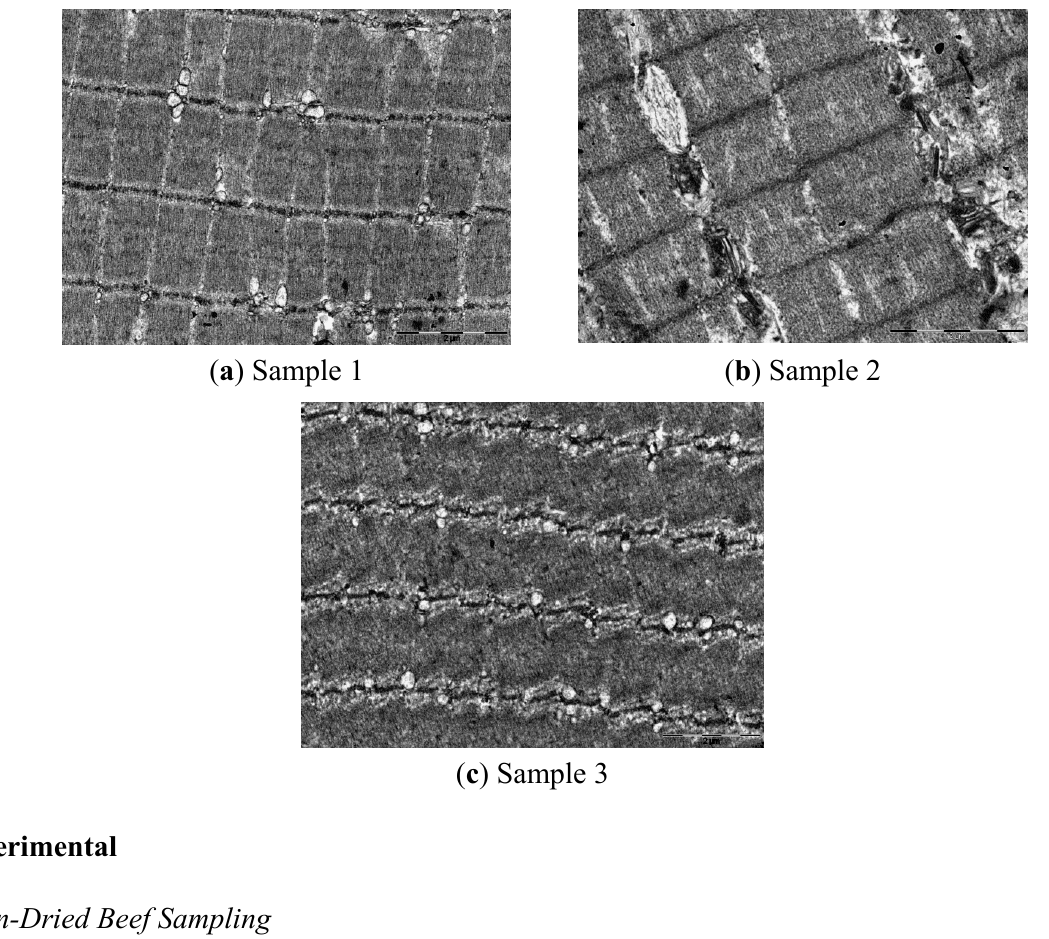
Figure 1. Sun-dried beef micrographs. Longitudinal sections of myofibrils. Magnification: ( a ) Sample 1 ( 11,000×); ( b ) Sample 2 (14,000×); ( c ) Sample 3